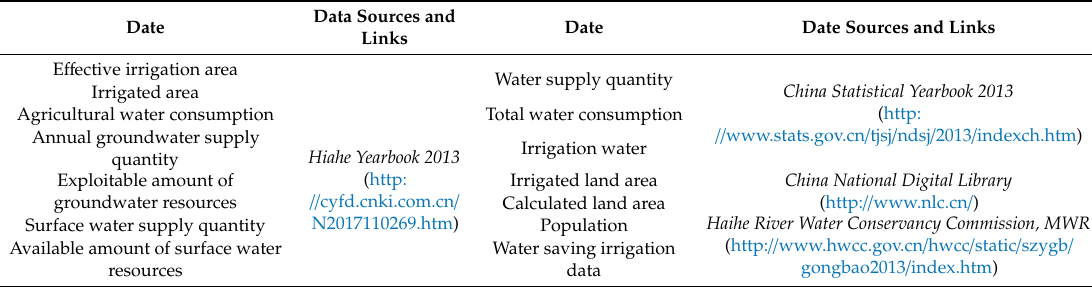
Table 1. Data and data sources.